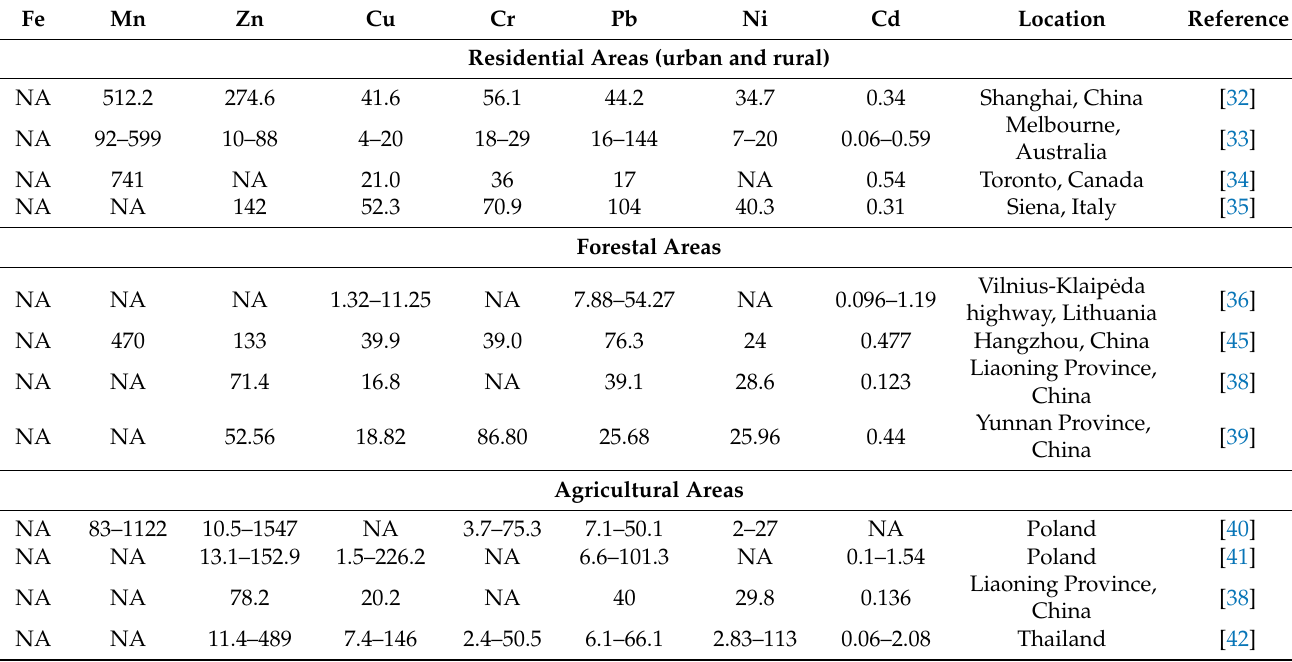
Table 5. Literature values of metal concentrations in soils near the roadway (mg · kg − 1